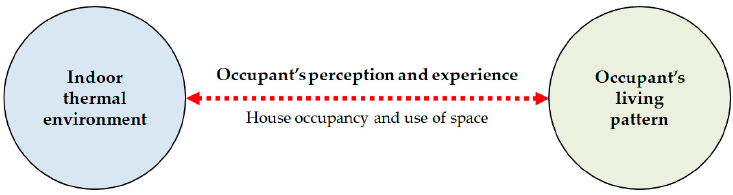
Figure 1. Conceptual framework of the study (Illustration: Author, based on literature